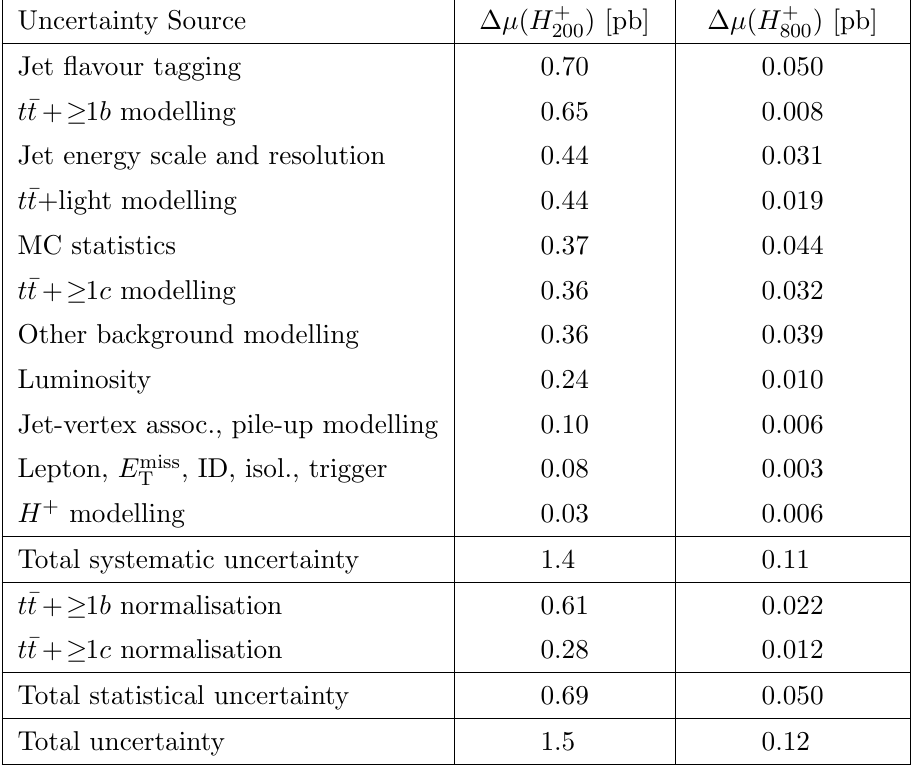
Table 5. The summary of the e(cid:11)ects of the systematic uncertainties on the signal strength pa- rameter, (cid:22) = (cid:27) ( pp ! tbH + ) (cid:2) B ( H + ! tb ), for the combination of the ‘ +jets and ‘‘ (cid:12)nal states is shown for an H + signal with a mass of 200 and 800 GeV. Due to correlations between the di(cid:11)erent sources of uncertainty, the total systematic uncertainty can be di(cid:11)erent from the sum in quadrature of the individual sources. The normalisation factors for both t (cid:22) t + (cid:21) 1 b and t (cid:22) t + (cid:21) 1 c are included in the statistical component. The total uncertainty corresponds to a best-(cid:12)t value of (cid:22) of (cid:0) 0 : 4 pb at m = 200 GeV and (cid:0) 0 : 02 pb at m = 800 GeV. The expected upper limit on (cid:22) is 3.05 pb at H + H + m = 200 GeV and 0.26 pb at m = 800 H + H +